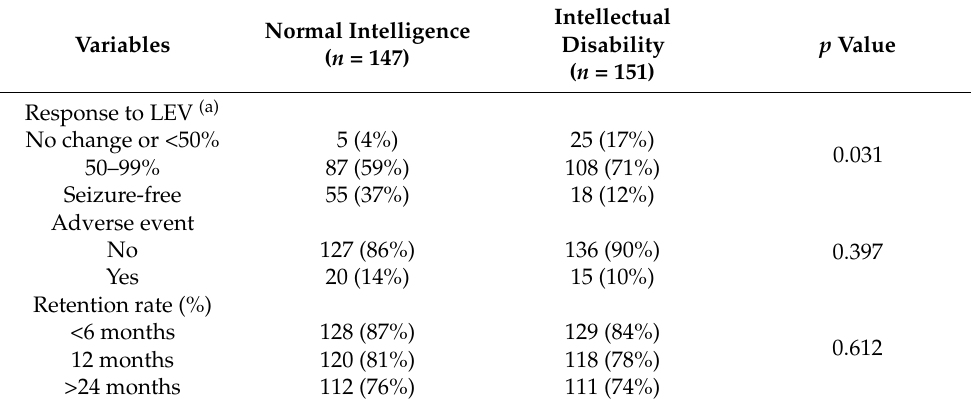
Table 2. Efficacy, safety, and tolerability of